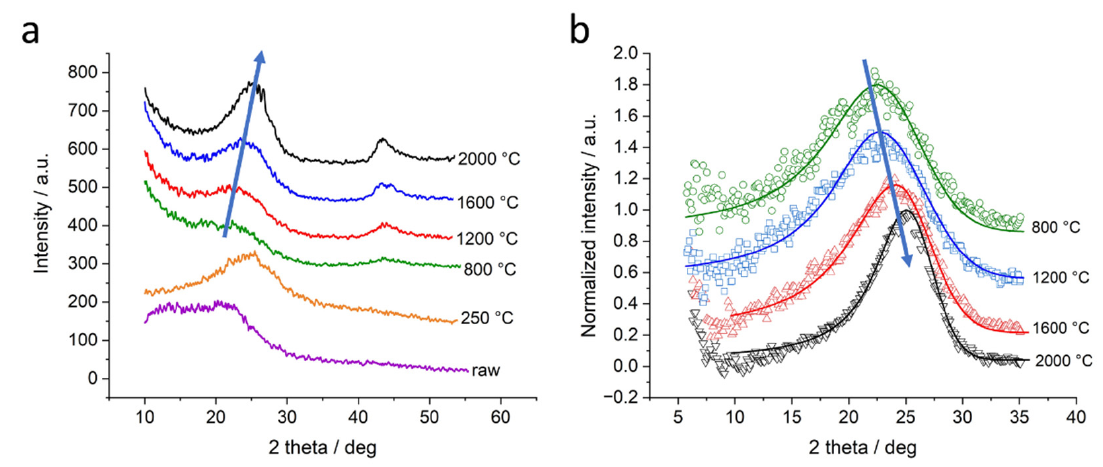
Figure 3. WAXD profiles of organosolv lignin-based samples. Curves are shifted by an arbitrary factor along the Y -axis: ( a ) curves of organosolv lignin-based samples for all temperatures; ( b ) fit function through (002)-peaks after subtraction of the low-angle signal of organosolv lignin-based samples displaying the shift and the narrowing of the (002)-peak with higher temperature. The peak shift is indicated with an arrow.